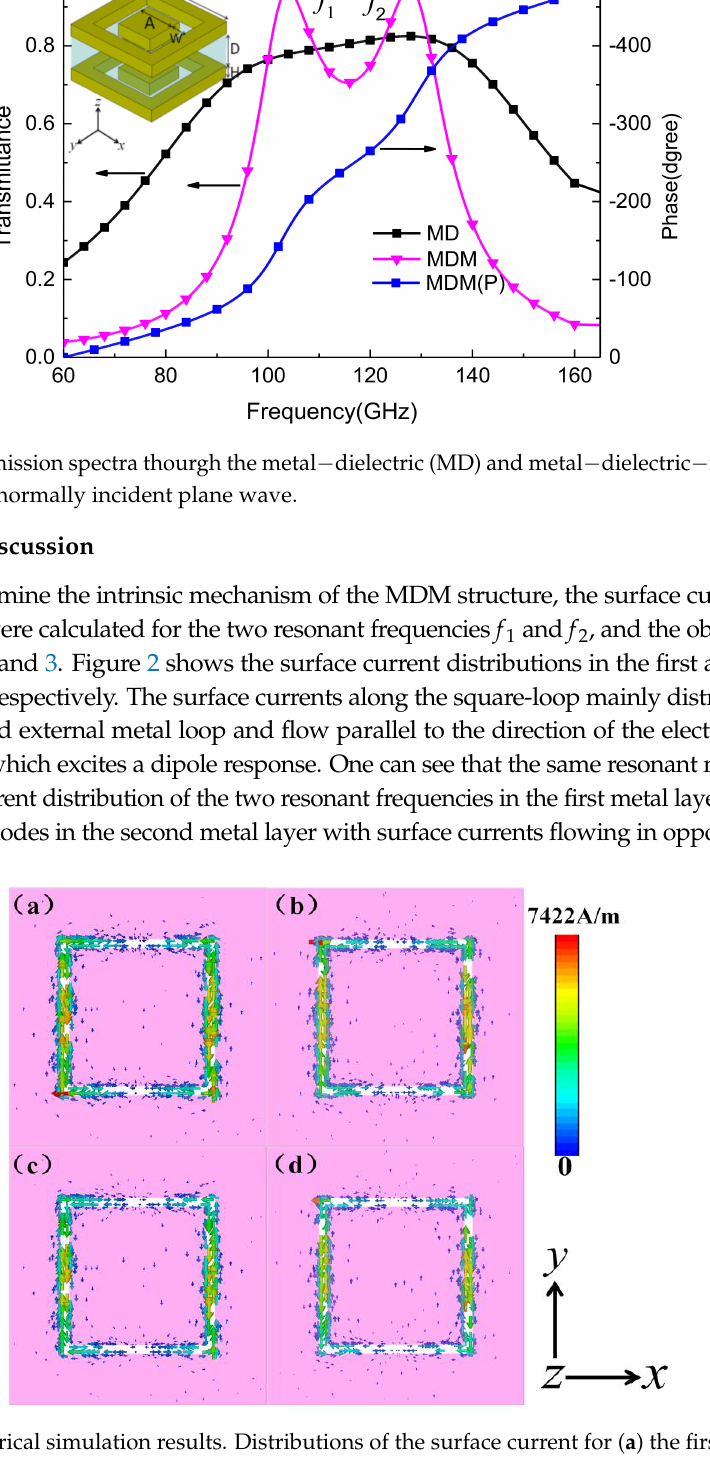
Figure 2. Numerical simulation results. Distributions of the surface current for ( a ) the first metal layer and ( b ) second metal layer in f 1 and ( c ) the first metal layer and ( d ) second metal layer in f 2